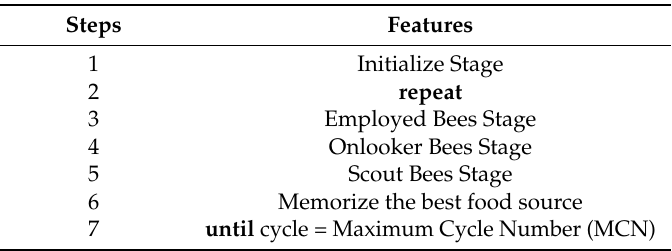
Table 2. The main steps of artificial bee colony (ABC)